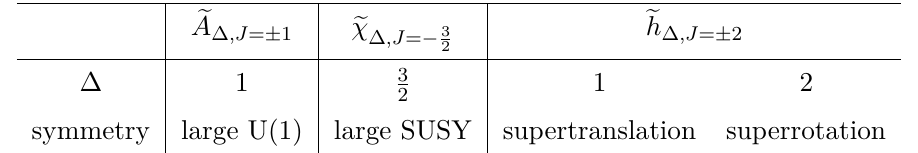
Table 4. Shadow Goldstone modes of spontaneously broken asymptotic symmetries for 1 ≤ s ≤ 2 .